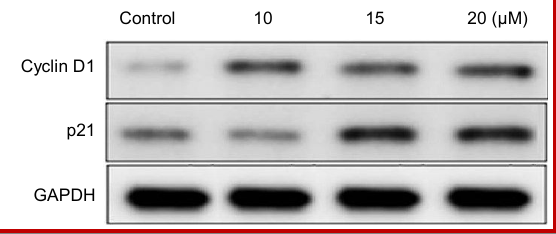
phase of cell cycle with subsequent decrease in S and G2/M on treatment with zerumbone. Thus, zerumbone treatment caused arrest of cell cycle in the G1 phase in DU-145 cells. Analysis of the expression of marker of G1 phase, cyclin D1 showed higher expression in zerumbone treated cells compared to the control